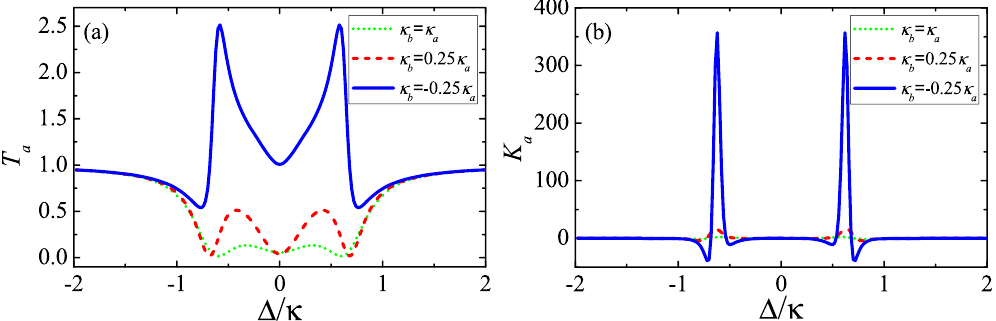
Figure 3. The linear transmission rate T a ( a ) and the third-order nonlinear intensity K a ( b ) as functions of the detuning Δ with κ b = κ a (green-dotted line); κ b = 0.25 κ a (red-dashed line) and κ b = − 0.25 κ a (blue-solid line). We set κ